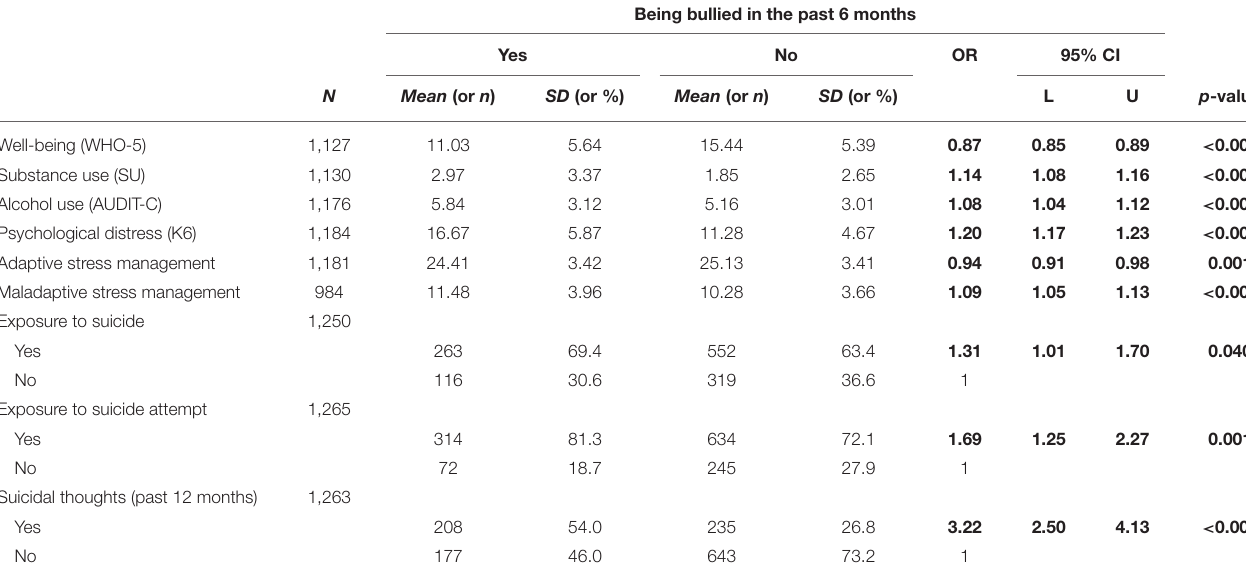
TABLE 3 | Subjective bullying in past 6 months by psychological scales and exposure to suicide (univariate